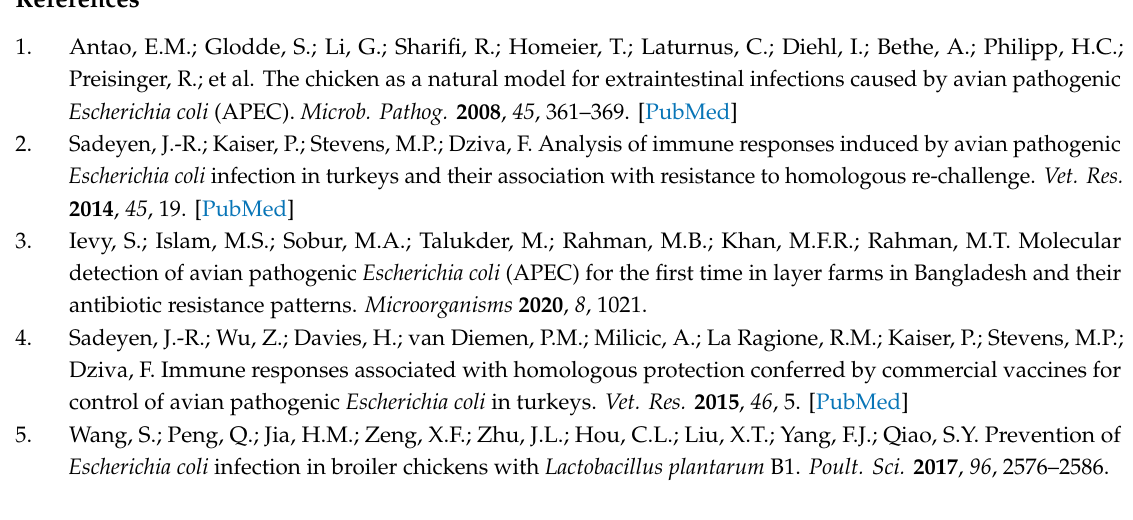
Table S1: Primers used for quantitative real-time PCR in this